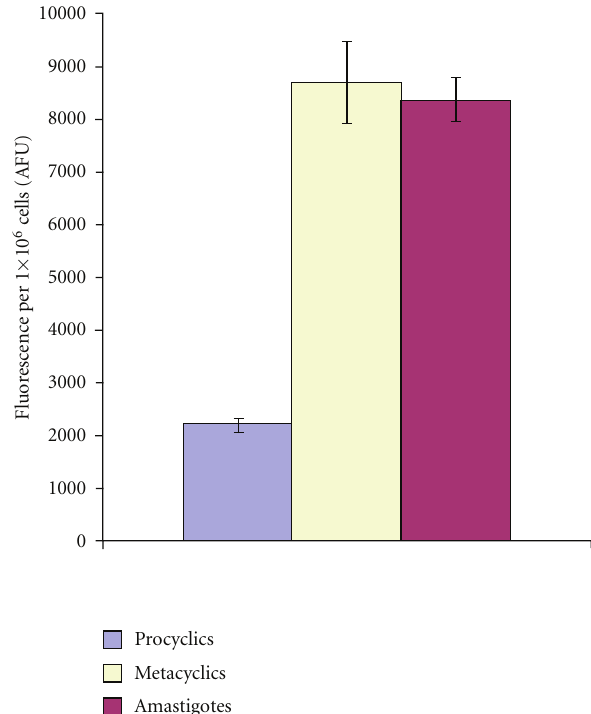
Figure 1: The endocytosis of Texan Red labelled dextran at 32 ◦ C measured as described and with the background (uptake in control parasites at 0 ◦ C) subtracted. Results from a representative experiment, in triplicate with standard deviation shown. AFU: arbitrary fluorescence